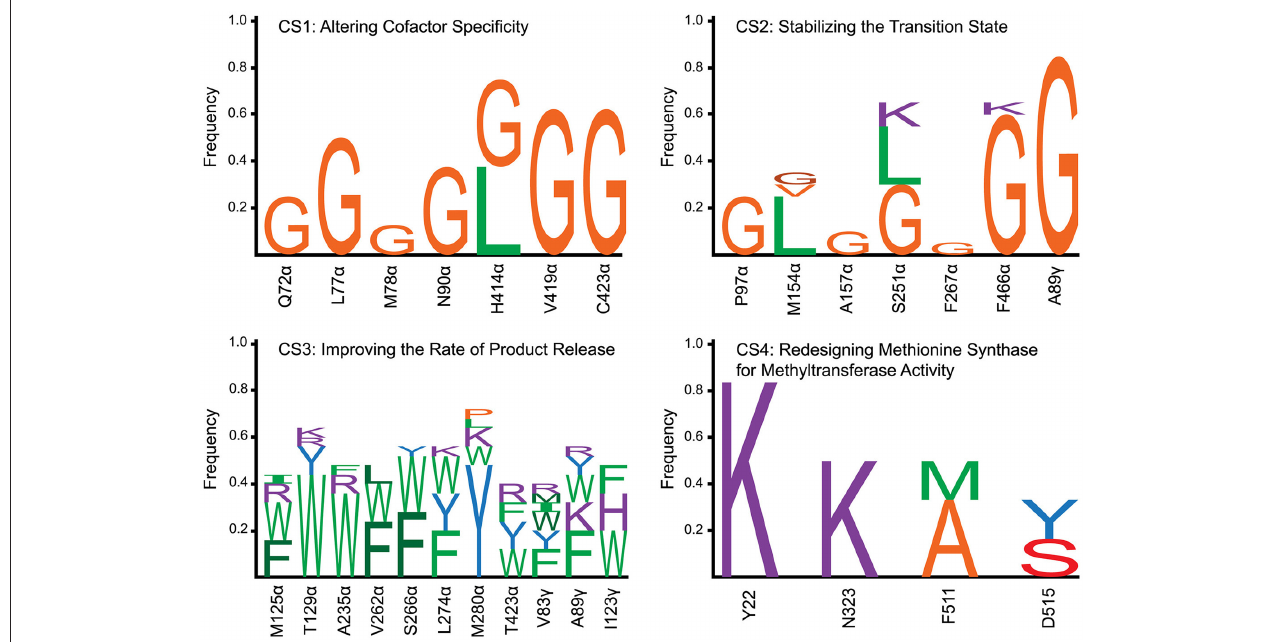
FIGURE 2 | Frequency of amino acid substitutions for each of the four case studies. For CS1, CS2, and CS4, all of the identified variants were incorporated into the frequency calculation. Due to the high number of variants identified in CS3, only the top 25 results were included within the plot. Wild-type amino acids are not included within the barcharts, accounting for the sum of the individual frequencies not adding to 1.0. The design positions are labeled by the wild-type one-letter amino acid code, position, and subunit (except for CS4 which only has a single subunit). Amino acid types were classified into five different categories and colored according to category. These categories were (1) large [ ≥ 162 Å 3 ( Pommié et al., 2004)] with a non-polar side chain (green), (2) small ( < 162 Å 3 ) with a non-polar side chain (orange), (3) large with a polar side chain (blue), (4) small with a polar side chain (red), and charged (purple). Different shades of the same color were used to distinguish stacked one-letter codes of the same amino acid